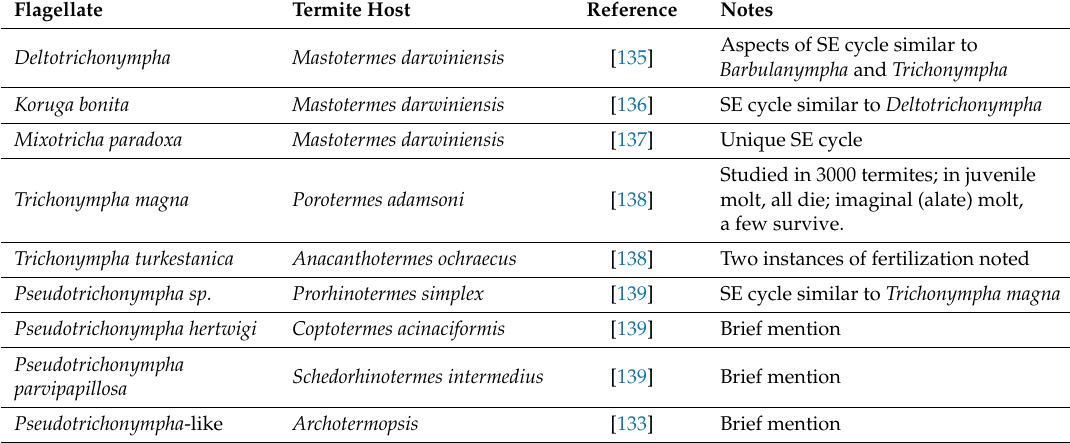
Table 2. Evidence for sexual/encystment (SE) cycles in the flagellates of termites. In each case except Trichonympha magna in Porotermes adamsoni alates, the cycles abort and the flagellates die prior to molt.